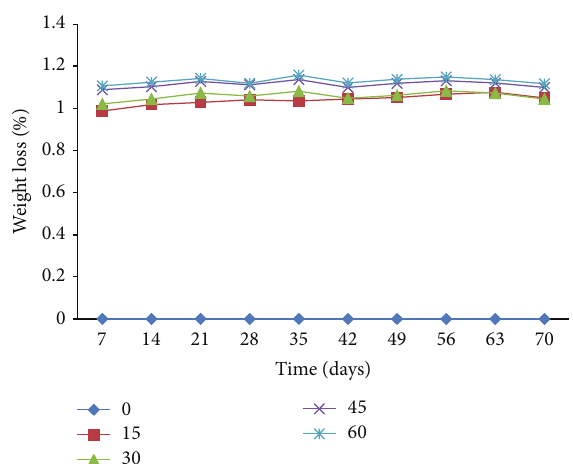
Figure 8: Weight loss after every 7 days at different RPIF Loading.